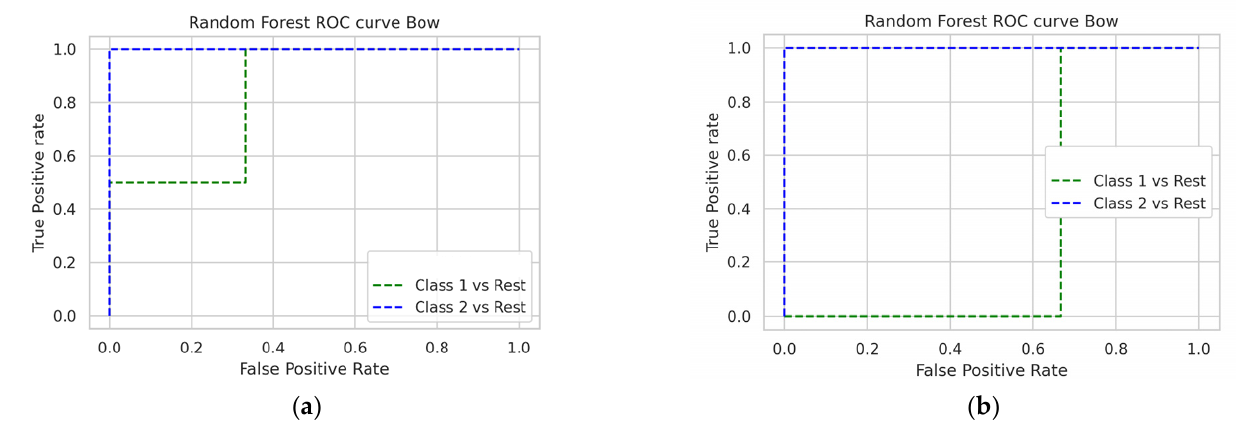
Figure 12. ROC curve for ACO on textual data ( a ) TF ‐ IDF and ( b ) BoW.